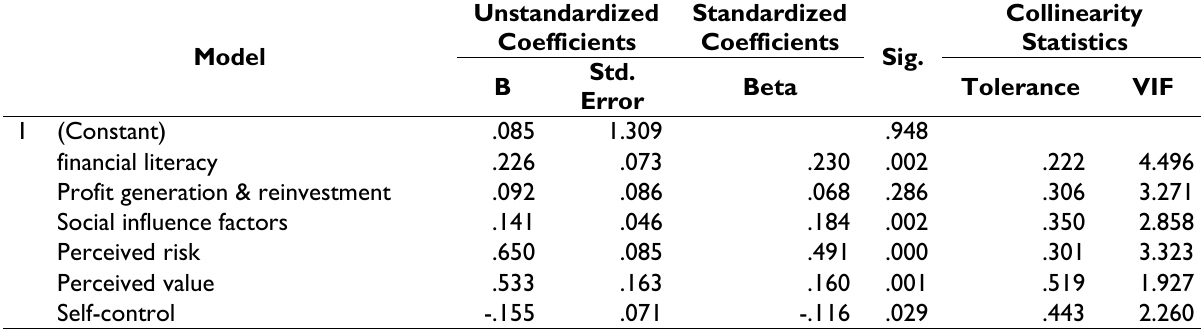
Table 9. Regression